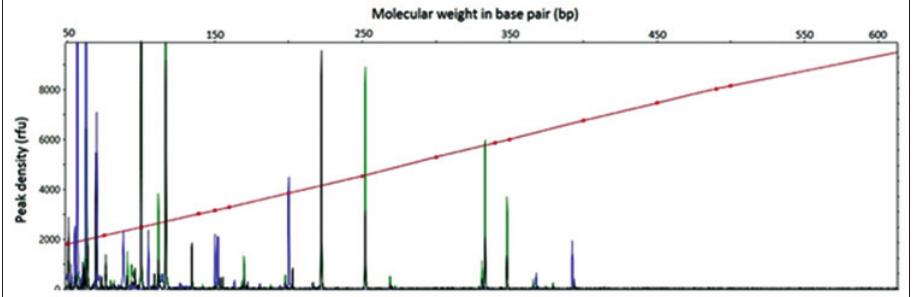
Figure-2: Fragment analysis chromatogram example of bulked sample no. 1 from Alexandria. Multiplexed selective amplified fragment length polymorphism-polymerase chain reaction of: FAM-Eco-ACA × Mse-CAA (blue peaks),